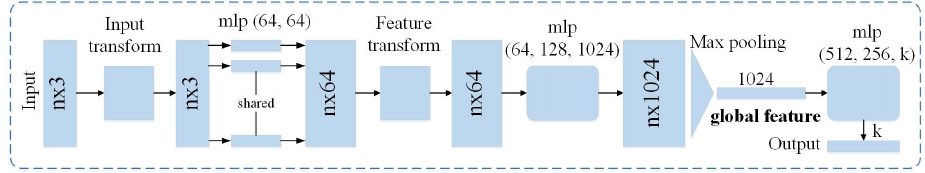
Figure 10. Architecture of